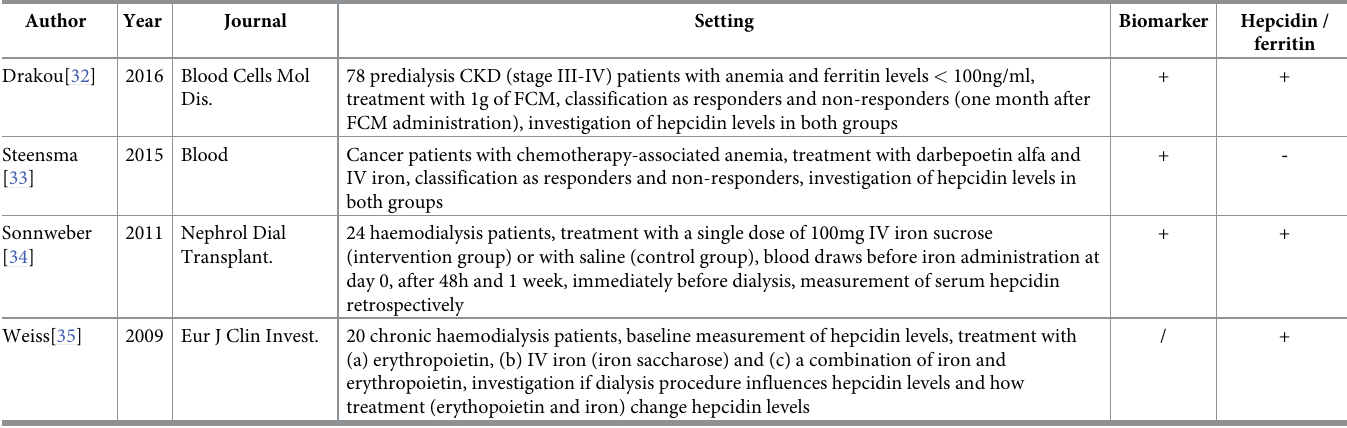
Table 4. Four studies that analyzed hepcidin as a potential biomarker and/or the correlation between hepcidin and ferritin.